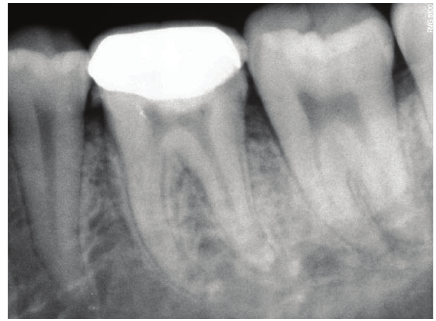
Figure 9: 6-month followup RVG 46.